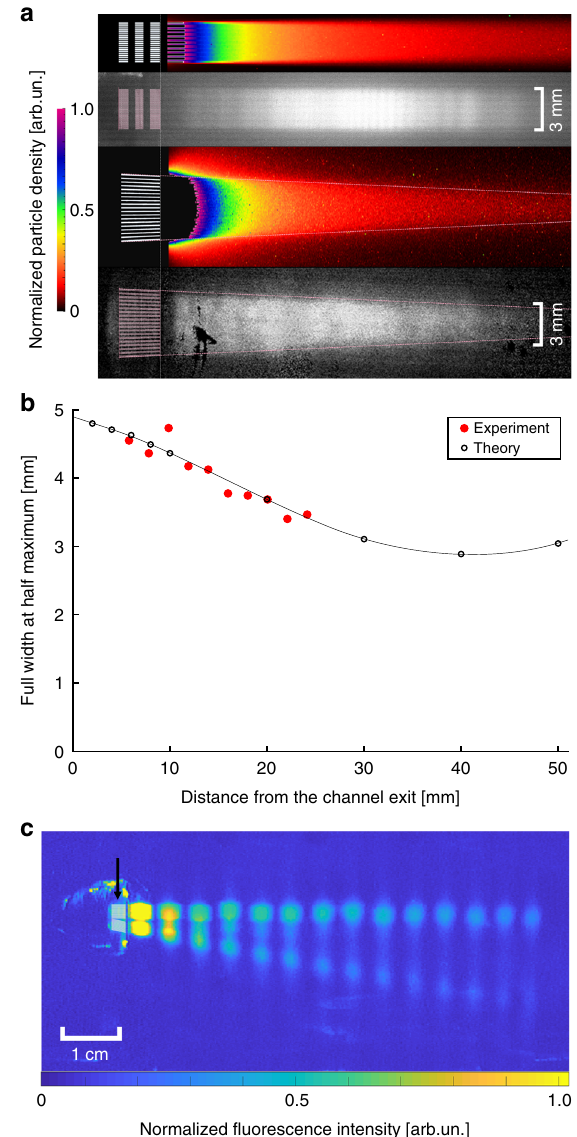
Fig. 5 A gallery of tailored atomic beams. From top to bottom are ( a ) cascaded collimator (theory, experiment), and focusing collimator (theory, experiment), b measured width of the focusing collimator along with Monte – Carlo theory (solid line), and c the two-beam collimator. In c the arrow points to the chip location. In a the experimental images were obtained by subtracting a background image with the laser tuned away from resonance so no atoms were visible. For the data in b the combination of image distortion and pixellation led to a spatial calibration uncertainty of 5% (9%) along the y -axis ( x